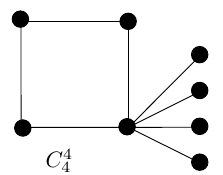
Figure 4. A C c n − c graph for n = 8 and c =